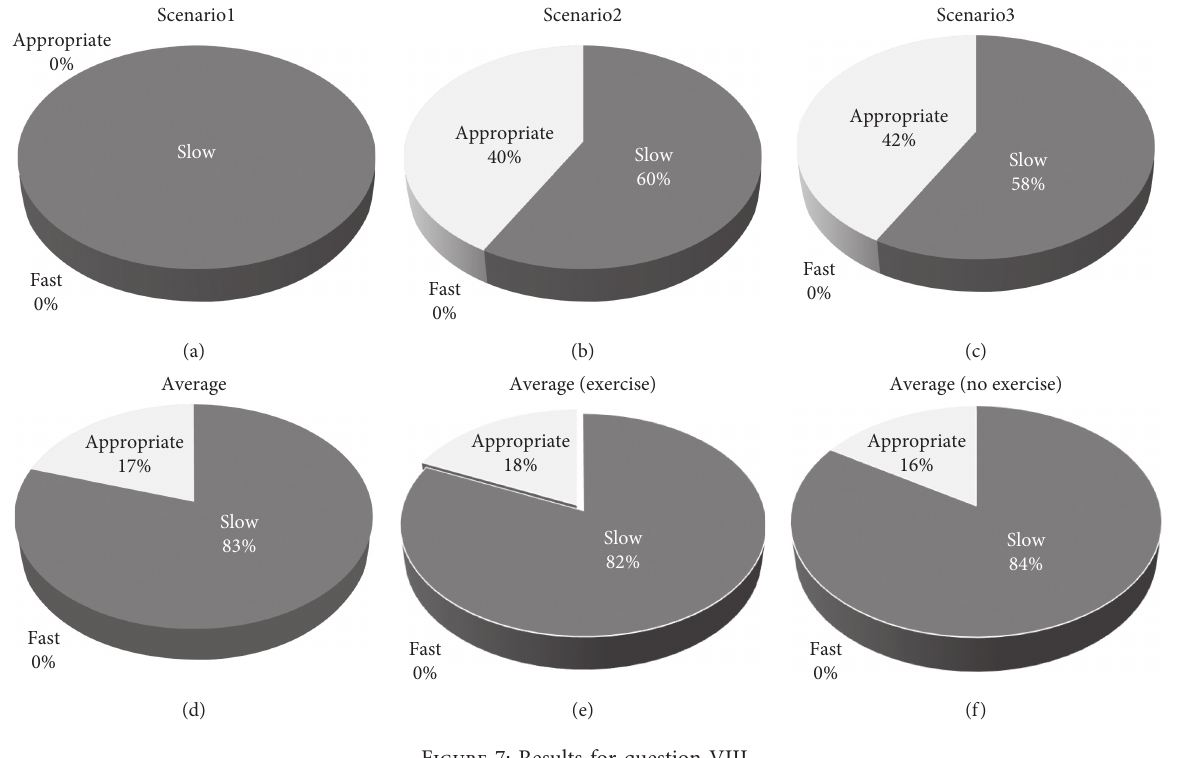
Figure 7: Results for question VIII. Table 5: Scenario 1 events categorized according to area (objective: